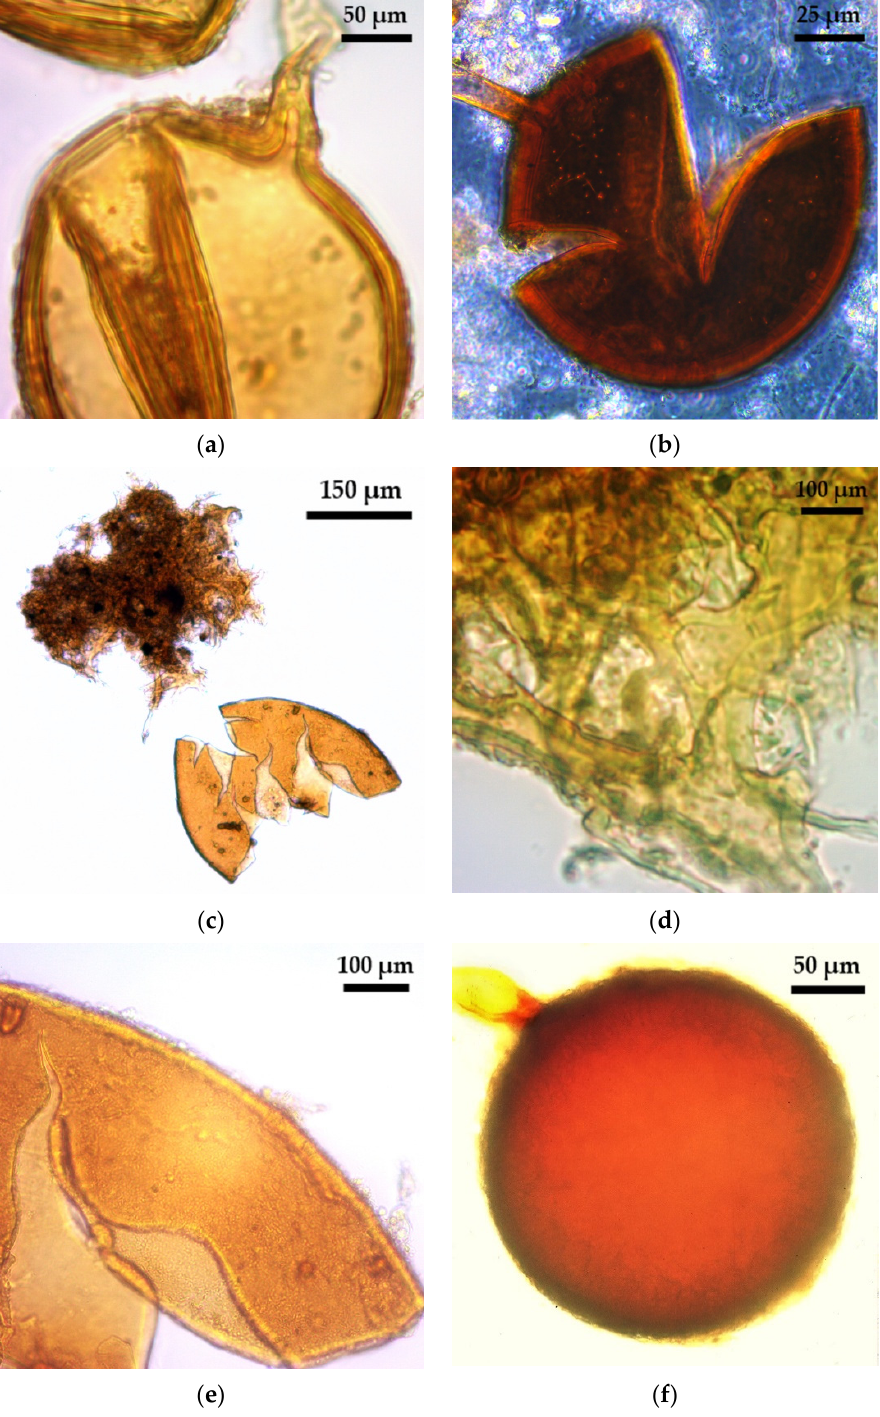
Figure 1. Glomoid AMF with single spores. ( a ) Funneliformis sp.; ( b ) F. geosporus ; ( c ) F. monosporus , general view of the spore and hyphal mantle or peridium; ( d ) F. monosporus , detail of the hyphal peridium; ( e ) F. monosporus , detail of wall ornamentations; ( f ) Septoglomus constrictum .